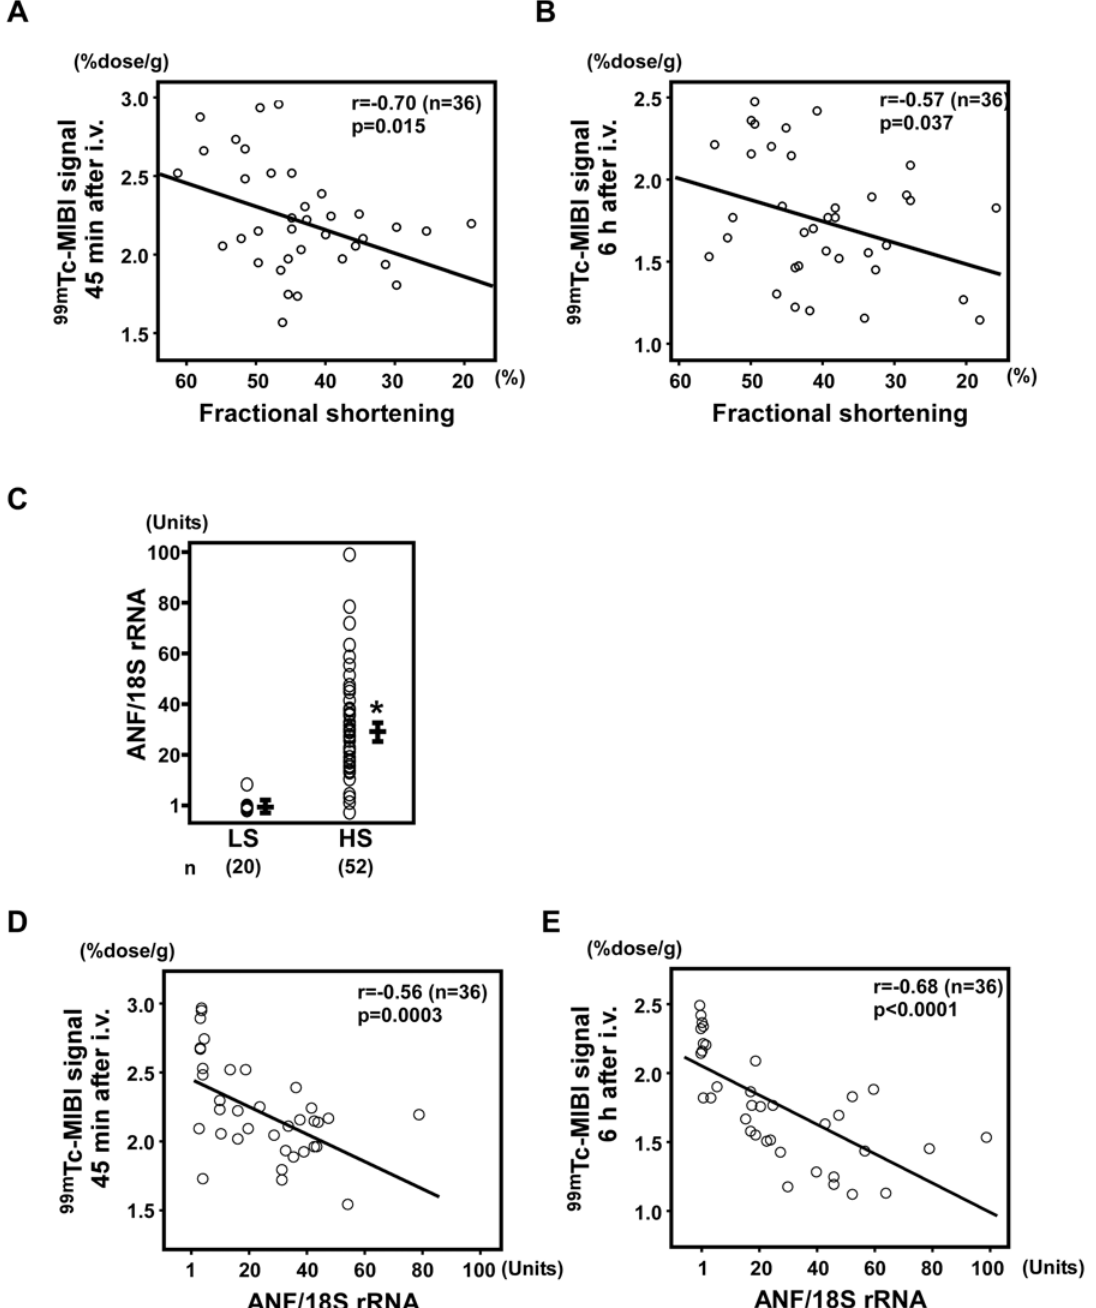
Figure 7. Correlation between 99m Tc-MIBI signals and cardiac function. (A, B) Correlation between fractional shortening on echocardiography and 99m Tc-MIBI signals 45 min after the injection (r = -0.70, n = 36, P = 0.015; A) or 6 h after the injection (r = -0.57, n = 36, P = 0.037; B). (C) Atrial natriuretic factor ( ANF) gene expression was significantly increased in DS rats fed an HS diet (HS; n = 52) compared to DS rats fed an LS diet (LS; n = 20). * P < 0.05 versus LS. (D, E) Correlations between ANF gene expression and 99m Tc-MIBI signals 45 min (r = -0.56, n = 36, P = 0.0003; D) and 6 h (r = -0.68, n = 36, P < 0.00001; E) after the